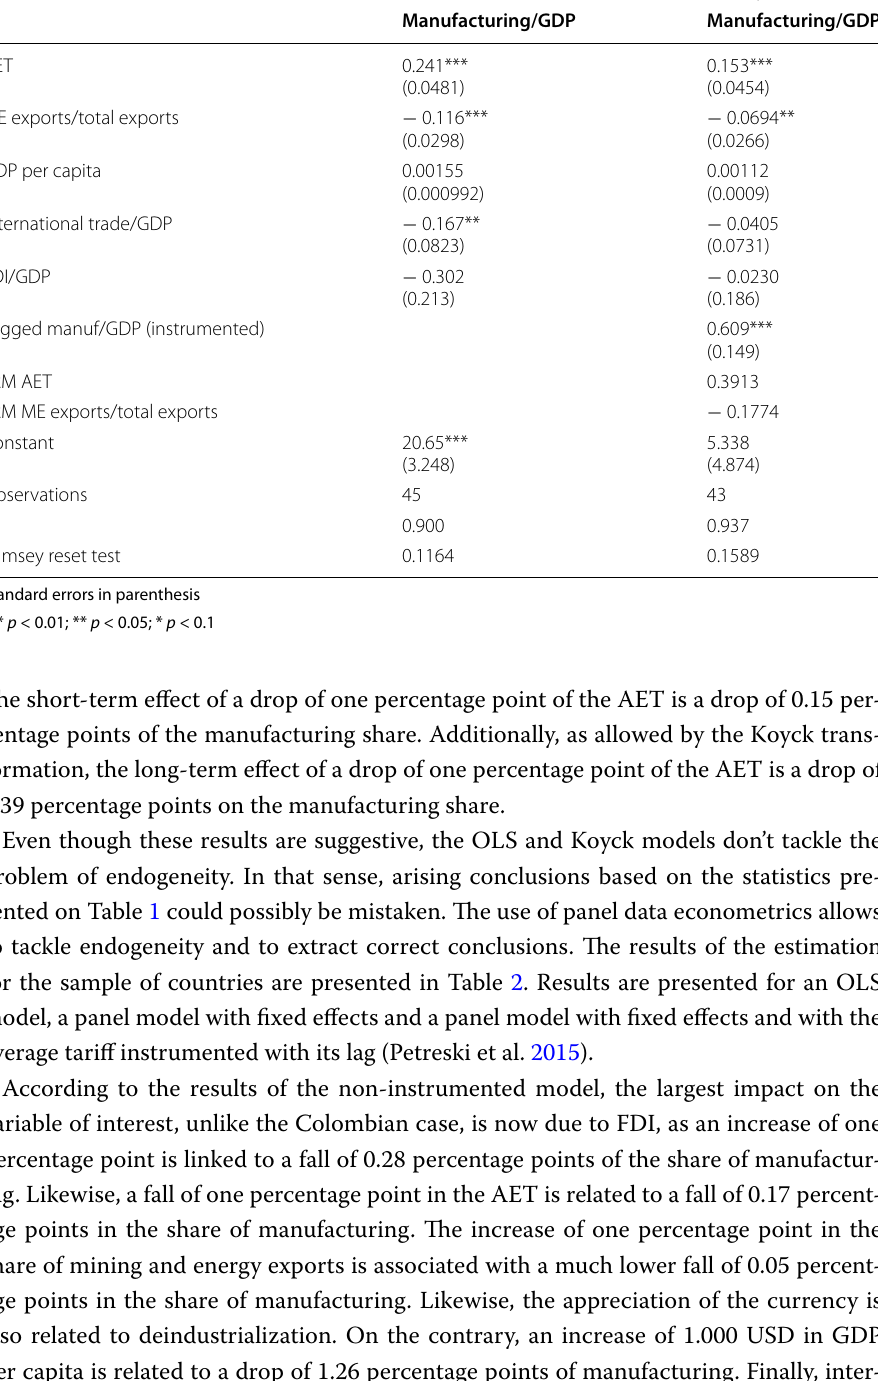
Table 1 Results for the Colombian case